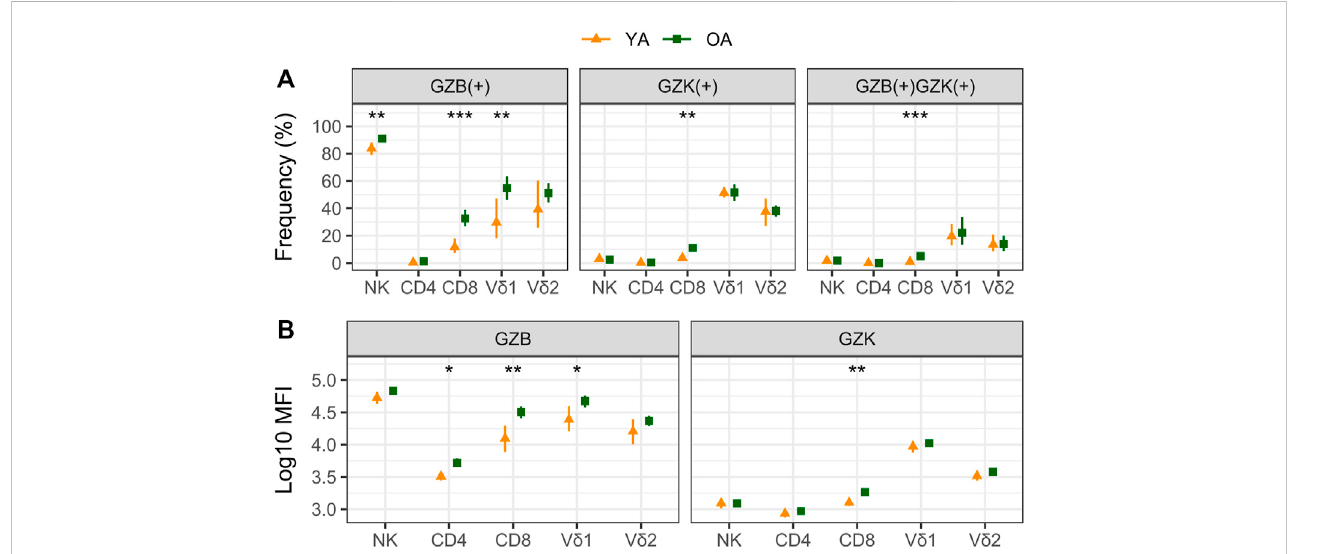
FIGURE 2 A comparison of granzyme B (GZB) and K (GZK) expression in young (YA) and older (OA) adults. The geometric mean and 95% con fi dence interval for (A) thefrequencyofGZB,GZKorGZB/GZK-expressingcells,and (B) themean fl uorescenceintensity(MFI)ofGZBorGZKexpressionwithinthosepopulationsare shown, with the signi fi cance of age-related differences determined by t -test on log-transformed values. ***, p < .001; **, p < .01; *, p < .05.